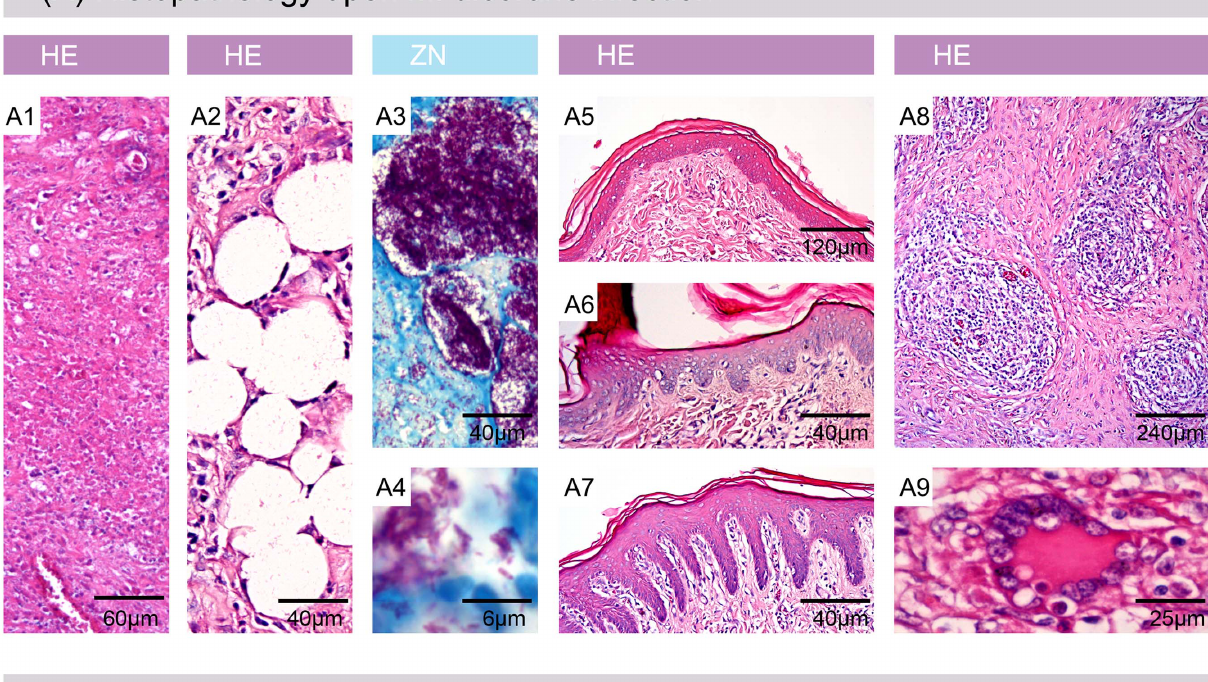
Figure 4. Containment of large amounts of AFB in the necrotic core and development of satellite microcolonies. Histologic sections stained with ZN. A plaque (A) and a small ulcer (B) are shown that developed 6.5 weeks after infection with 2 6 10 7 CFU. The ulcerated lesion was strongly infiltrated at the site of ulceration, where no AFB were found (Region 1, B1, B2). Lateral and between dermis and muscle tissue infiltrating cells enclosed small necrotic areas (Region 2, B3), where AFB were found as satellite microcolonies (B4, B5). The plaque consisted of distinct layers of infiltrating cells encasing a necrotic core containing large clumps of bacteria (Ring 1, A1, A2). A second and third ring with decreasing bacterial load and integrity and increasing integrity of infiltrating cells were layered around this core (Ring 2, A3, A4 and Ring 3, A5, A6). A belt of intact cells was surrounding these three inner layers. It did not contain any AFB (Ring 4, A7) except for a microcolony peripheral to the main bacterial burden (Ring 5, A8).